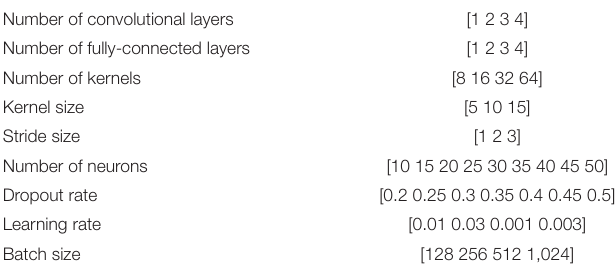
were manually reviewed to ensure that no false detections were included.